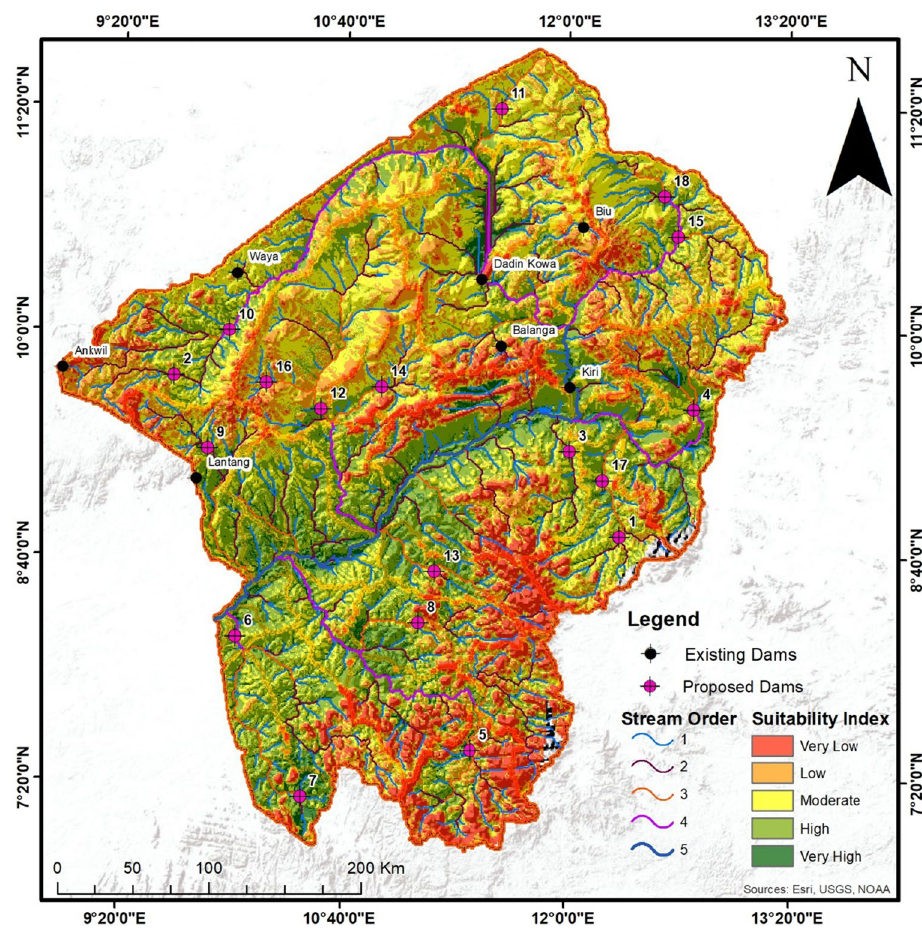
Fig. 10 Locations of potential small hydropower sites in Upper Benue